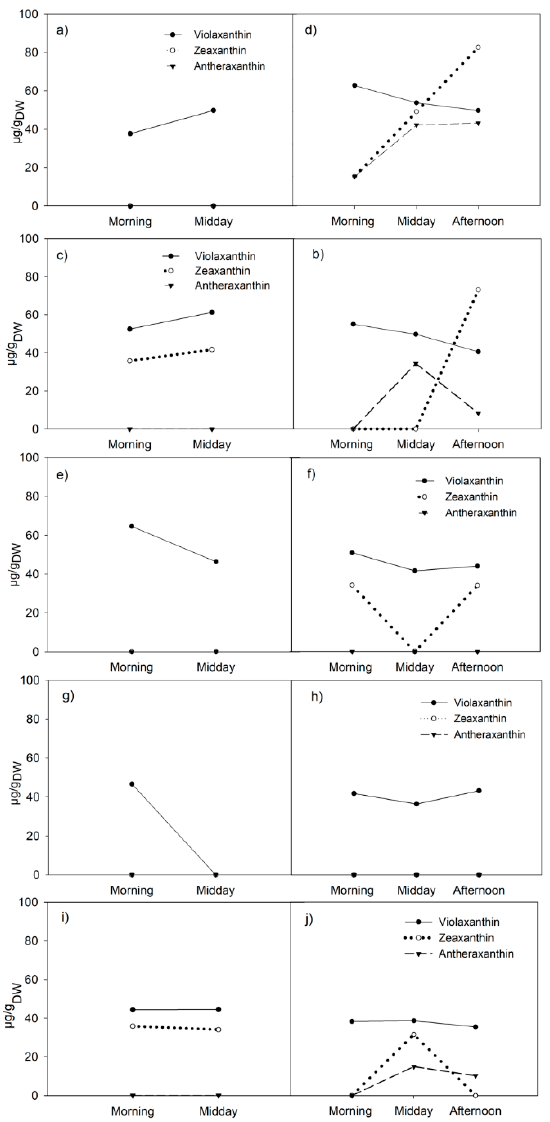
Figure 2. Diurnal variations in xanthophyll cycle pigments in Festuca curvifolia ( a , b ), Jurinea humilis ( c , d ), Erysimum penyalarense ( e , f ), Senecio carpetanus ( g , h ), and Hieracium vahlii ( i , j ) collected at the highest site (2244 m) at the optimum of plant activity in 2018 (left panel) and 2019 (right panel),